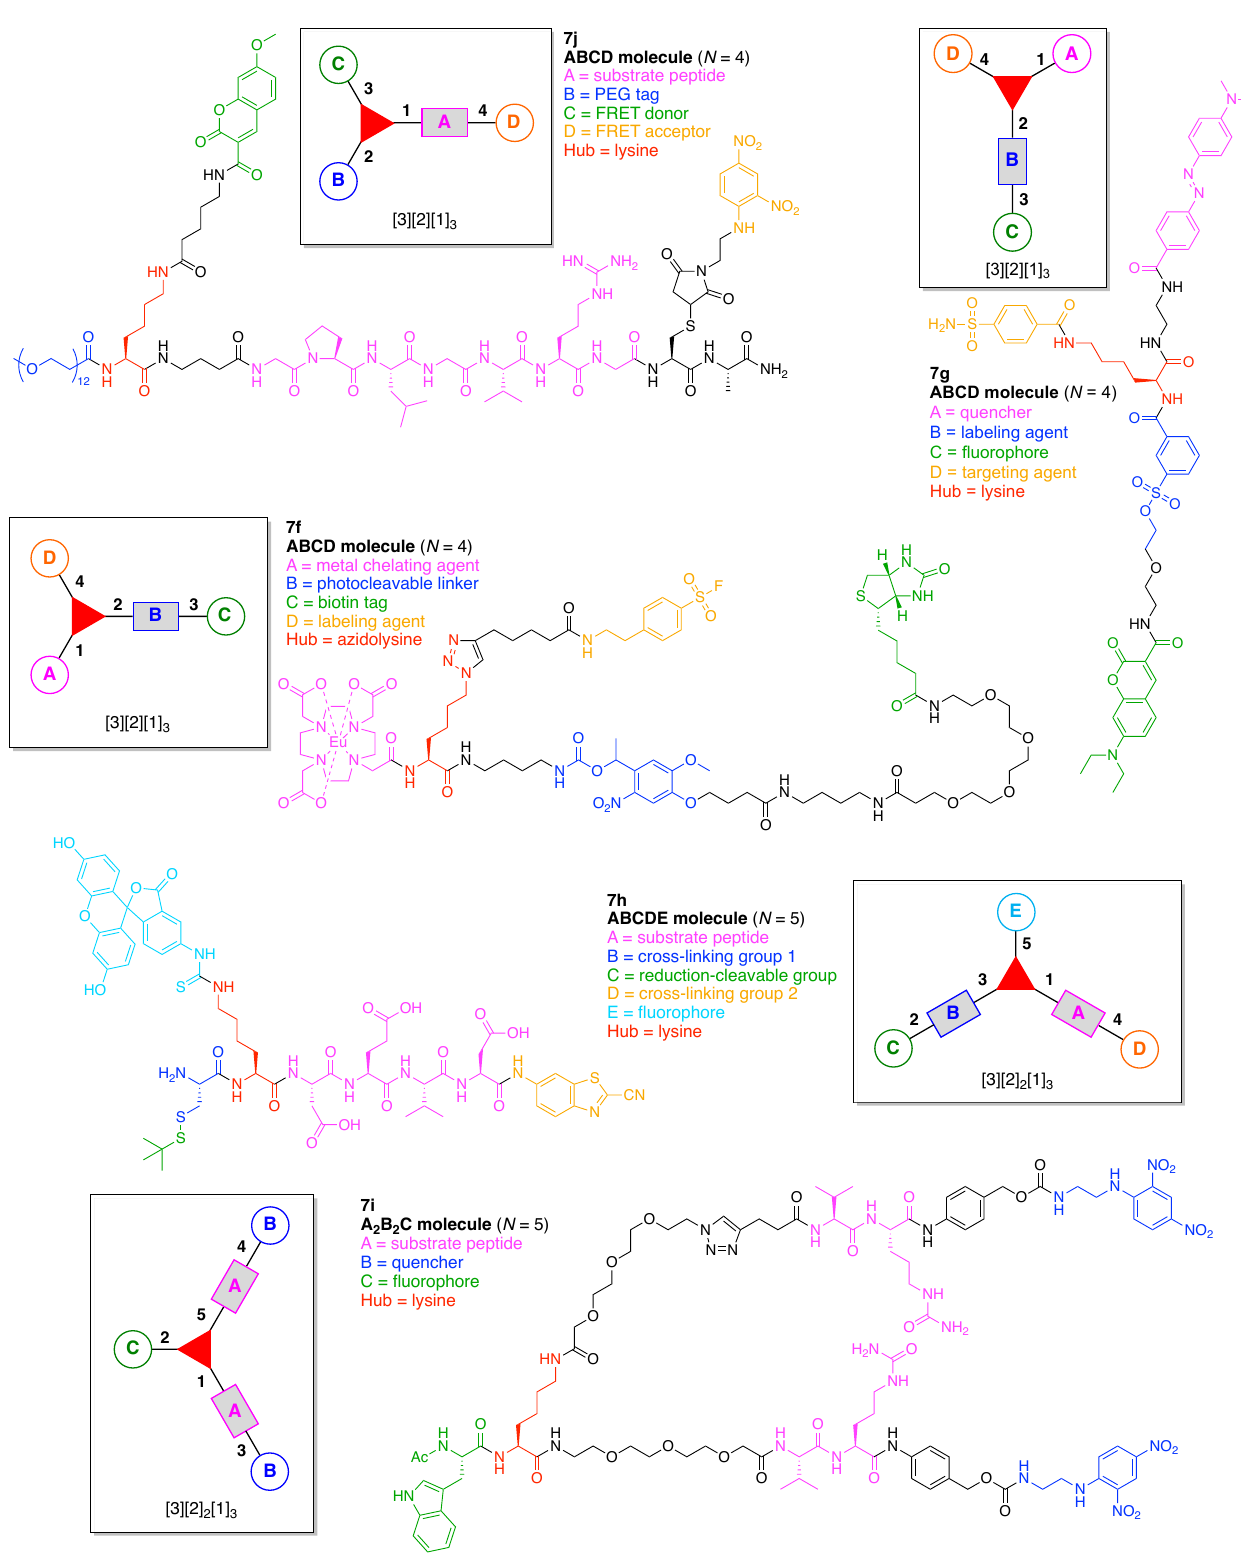
Figure 14. Five examples each with a single Lys hub.